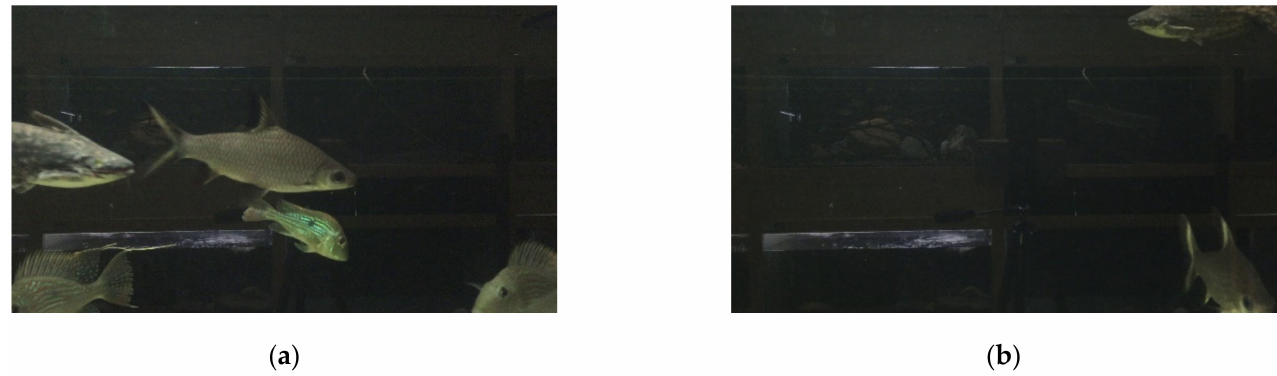
Figure 1. The sample aquatic subject frames, ( a ) multiple subjects and ( b ) low-contrast subjects in their